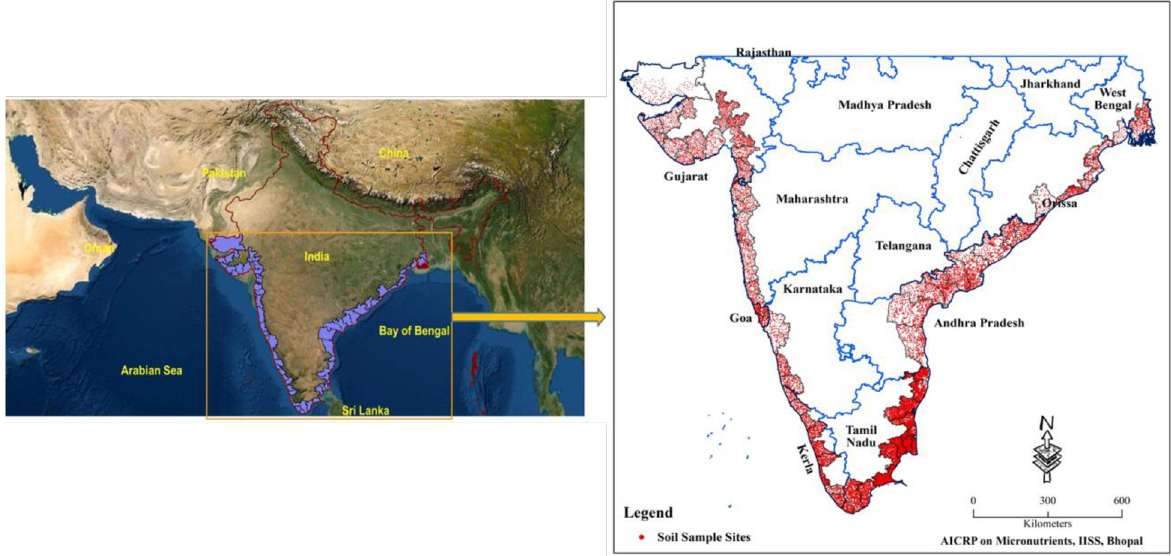
Fig 1. Soil sample locations in study